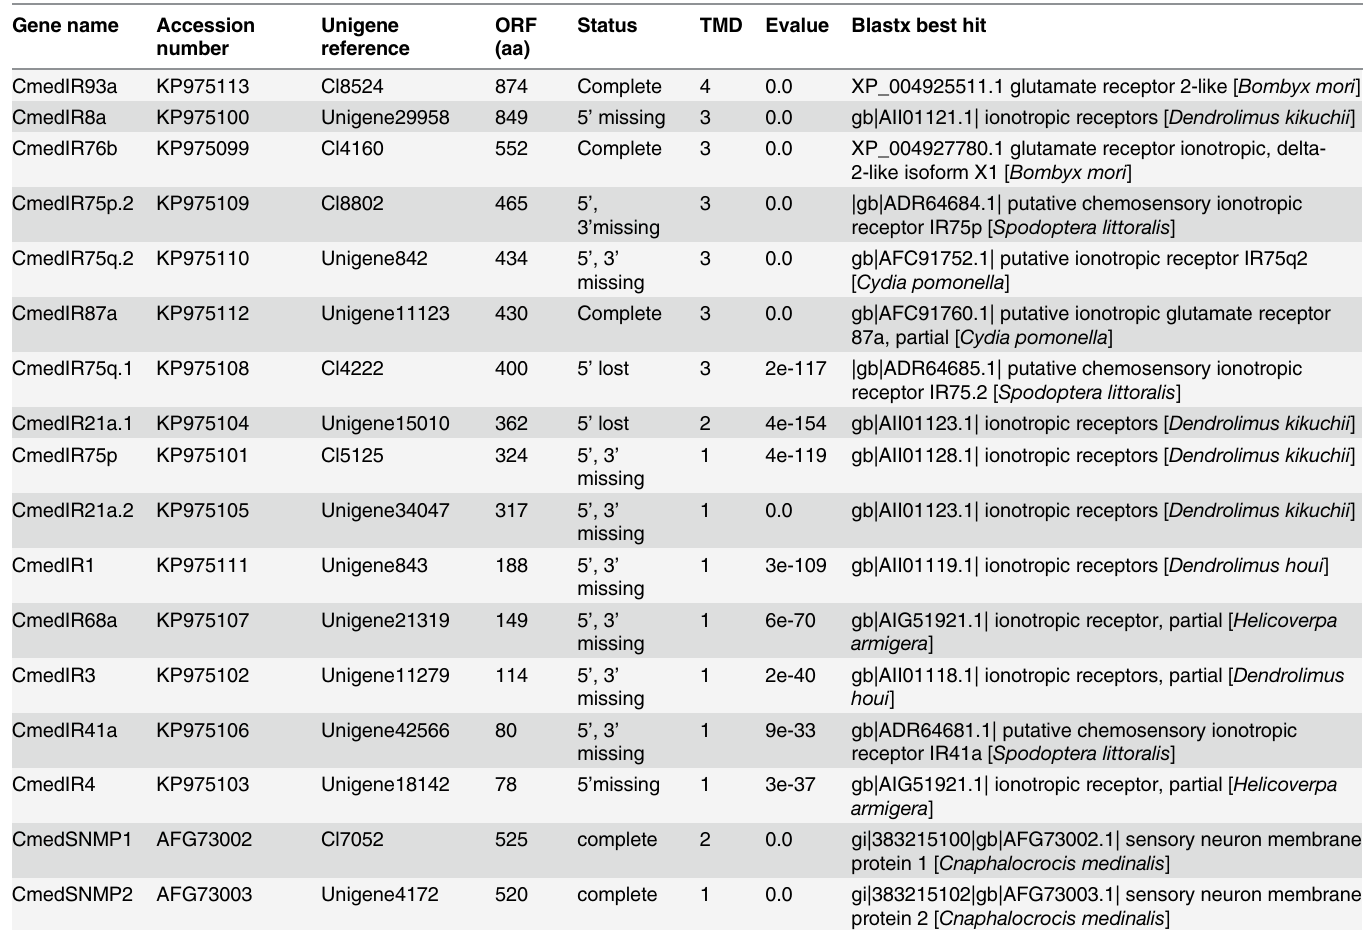
Table 4. Unigenes of candidates for ionotropic